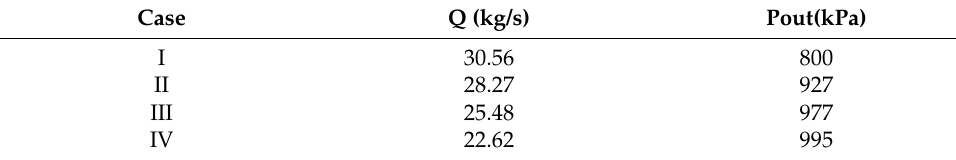
Table 2. Correspondence of flow and outlet static